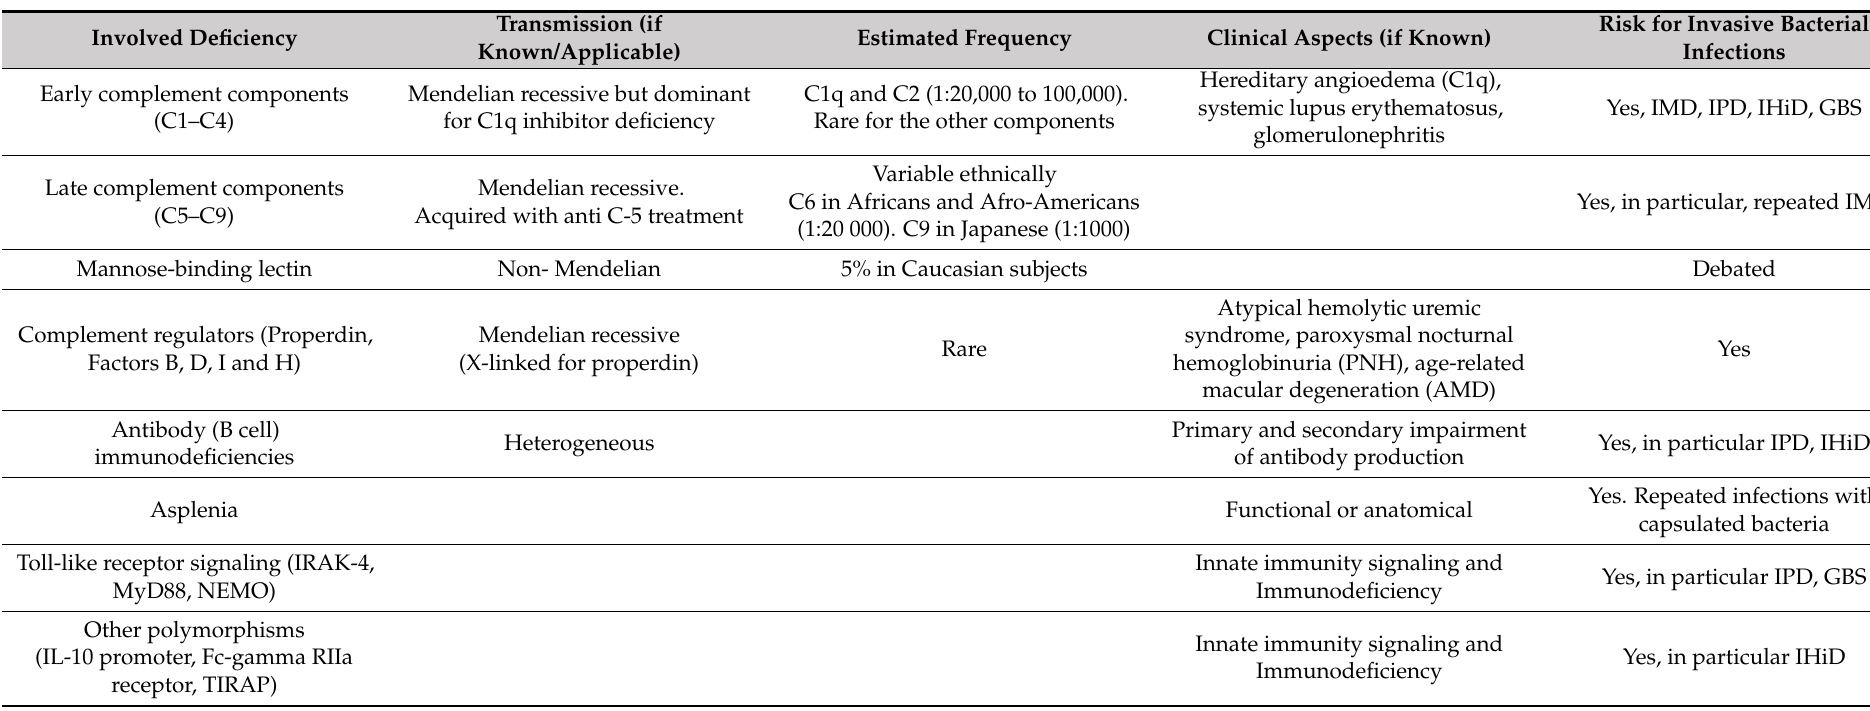
Table 1. Congenital and acquired deficiencies and anatomic conditions that may predispose to meningococcal, pneumococcal, H. influenzae or GBS invasive infections requiring prevention strategies against invasive bacterial diseases (adapted from references cited in the